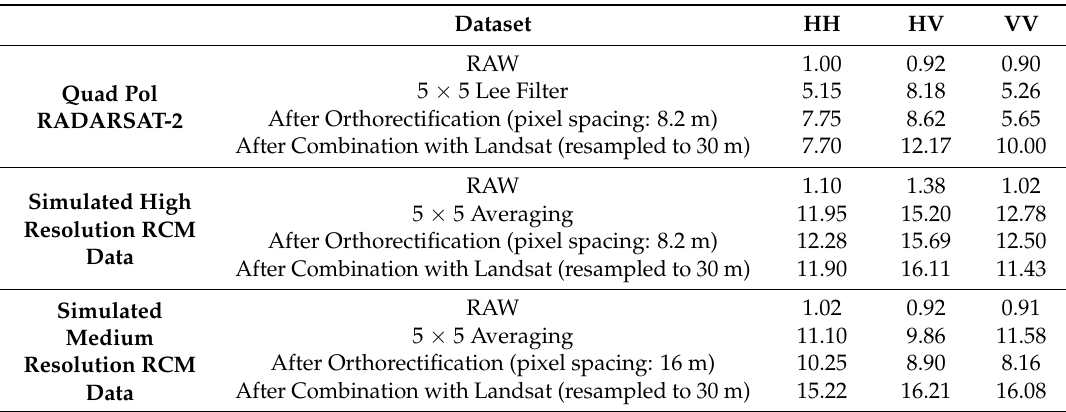
Table 5. Estimated ENL for all RADARSAT-2 images evaluated in this research. ENL: Equivalent Number of Looks.